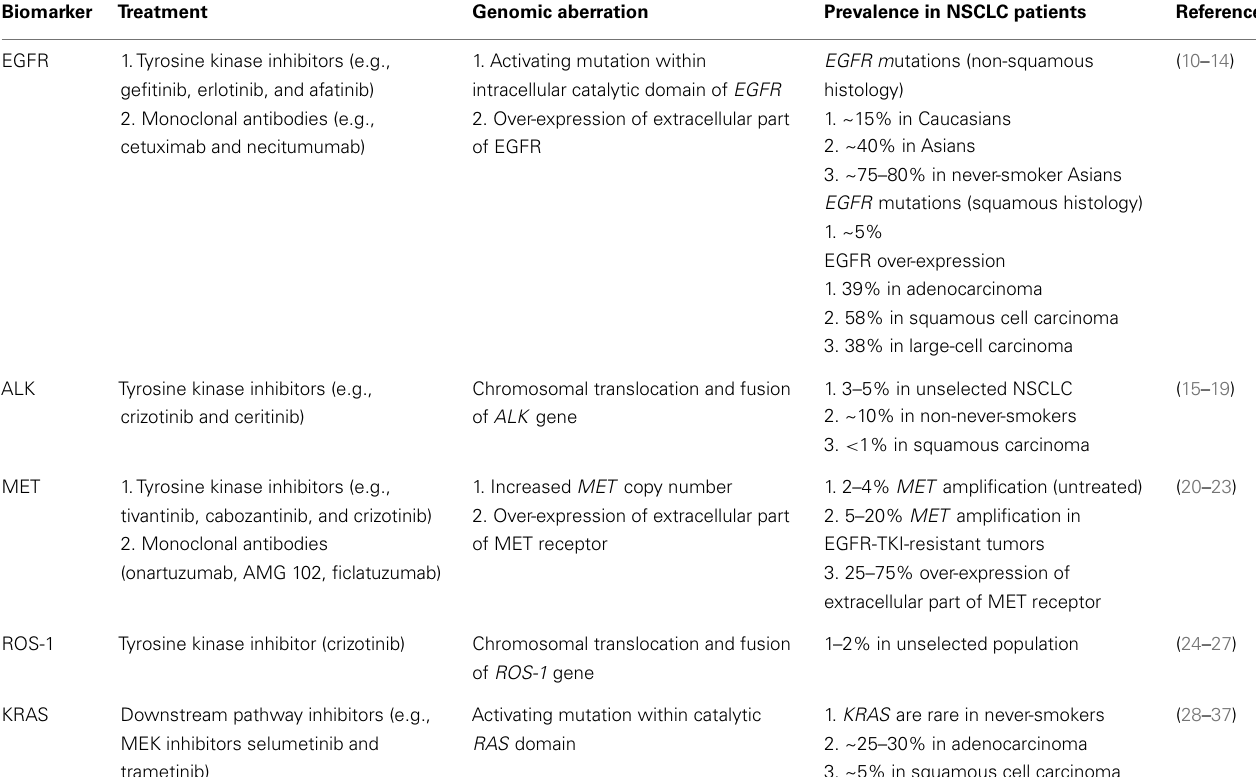
Table 1 | Clinically relevant biomarkers in NSCLC